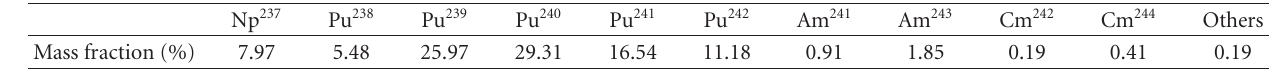
Table 4: PBMR HM composition after 713 EFPD.